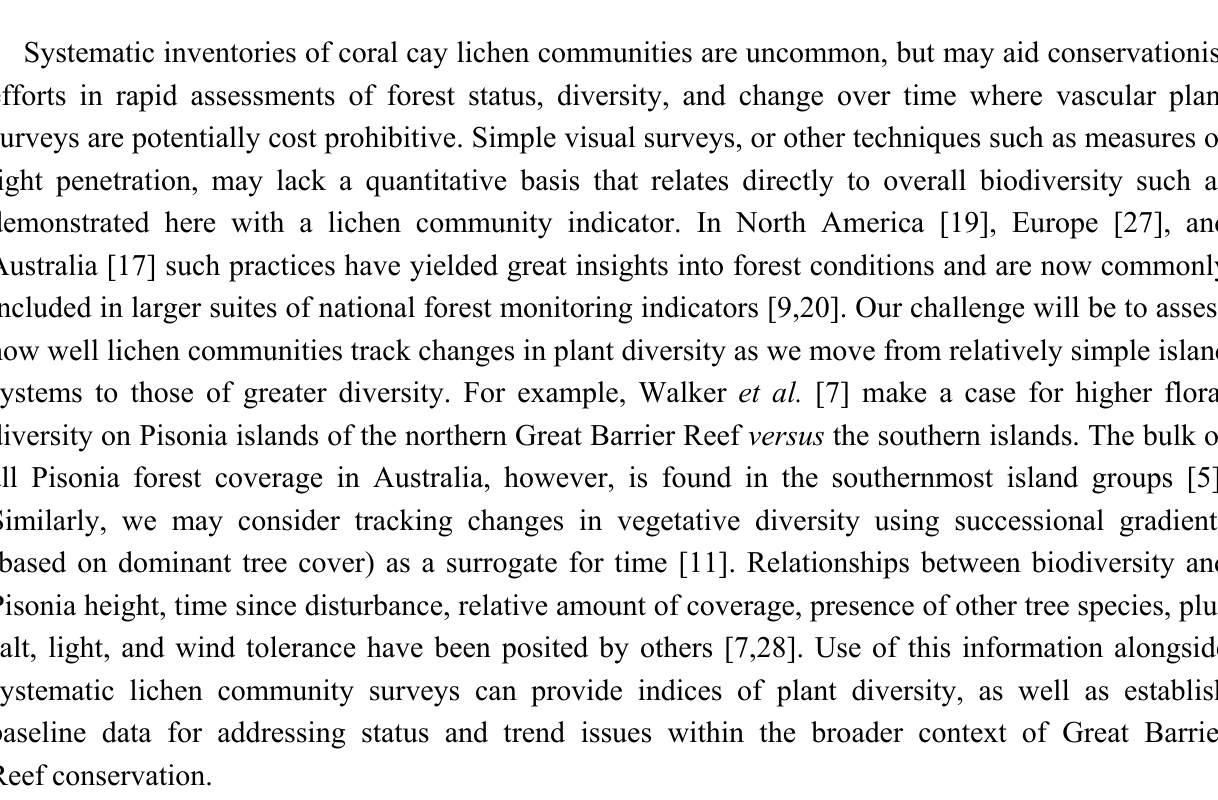
Figure 4. Highly shaded Pisonia ( Pisonia grandis ) forests support few understorey plants or arboreal lichens. Shearwater nests are visible as excavated holes and sandy mounds across the forest